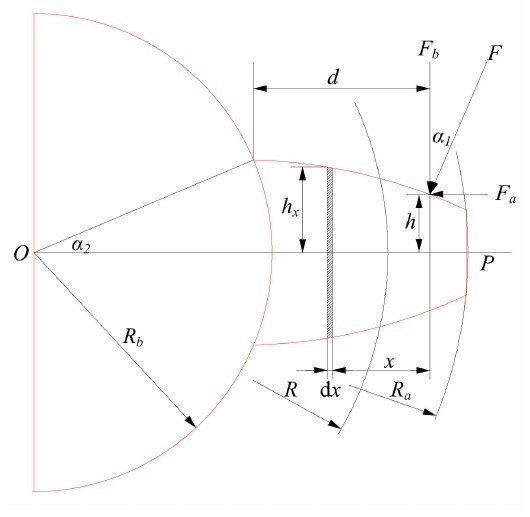
Figure 3. Cantilever beam